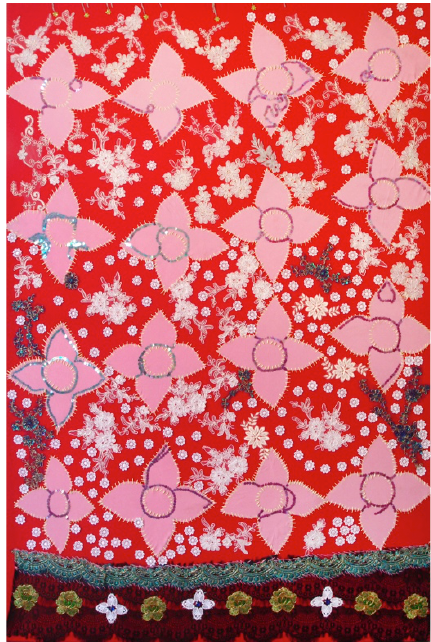
Chan Dany, Sampot: The Collection of Small Things (More Dok Chan Flowers), 2012. Lycra, lace, plastic beads, sequins, cotton thread. 100 x 150cm. Photograph by Lim Sokchanlina. Coutesy of the artist and SA SA